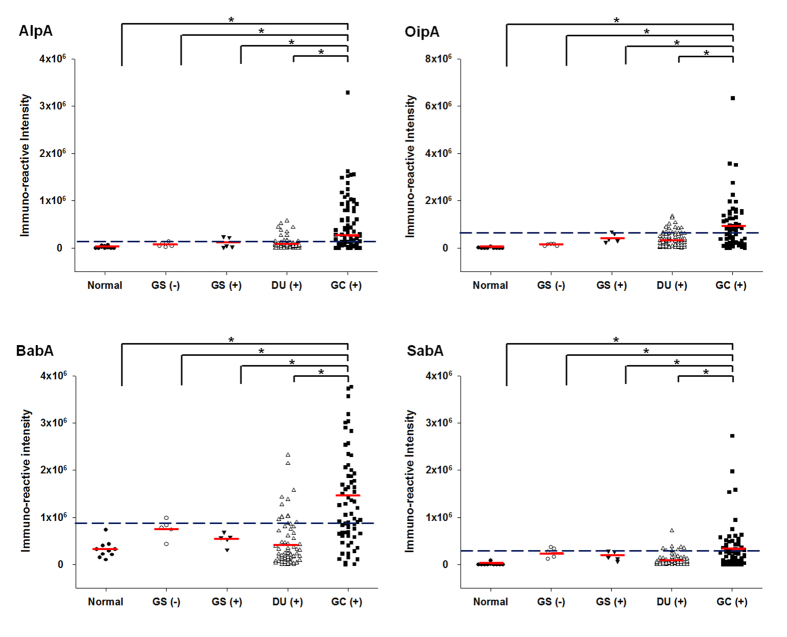
Seroreactivity for AlpA, OipA, BabA, and SabA in normal subjects and patients with gastritis, DU, or GC.Purified recombinant AlpA, OipA, BabA, and SabA were probed with clinical serum samples by Western blotting and the relative immunoreactivity was measured and analyzed. The subjects were healthy individuals without H. pylori infection (n = 10), gastritis patients without H. pylori infection [GS (−), n = 5], gastritis patients with H. pylori infection [GS (+), n = 5], duodenal ulcer patients with H. pylori infection [DU (+), n = 80], and gastric cancer patients with H. pylori infection [GC (+), n = 76]. The horizontal red lines indicate the mean values for each group and the black dotted line indicates the cut-off value for seropositivity defined as the mean ± 2SD of the non-GC samples. *p < 0.05.